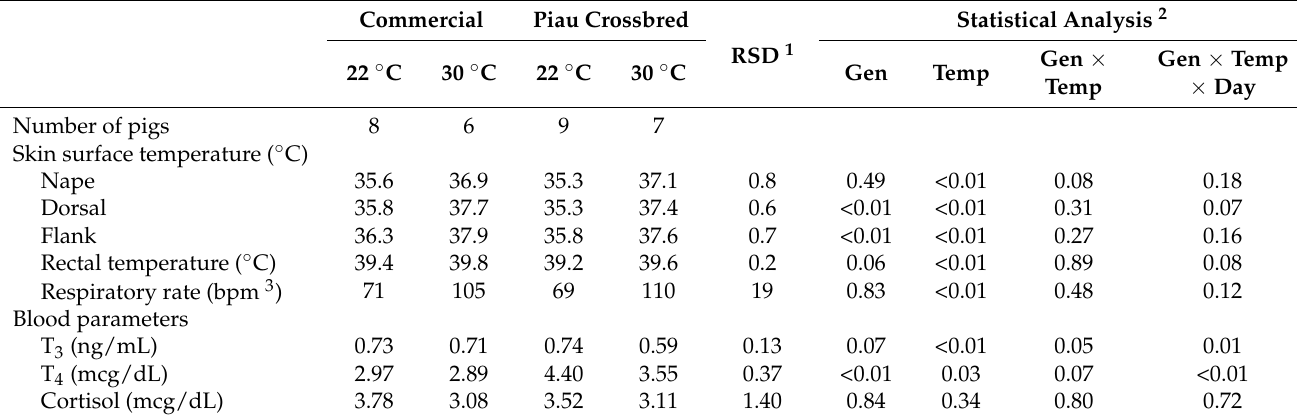
Table 2. Ambient temperature effects on thermoregulatory responses and blood parameters of commercial and crossbred (Brazilian Piau purebred sires × commercial dams) pigs.